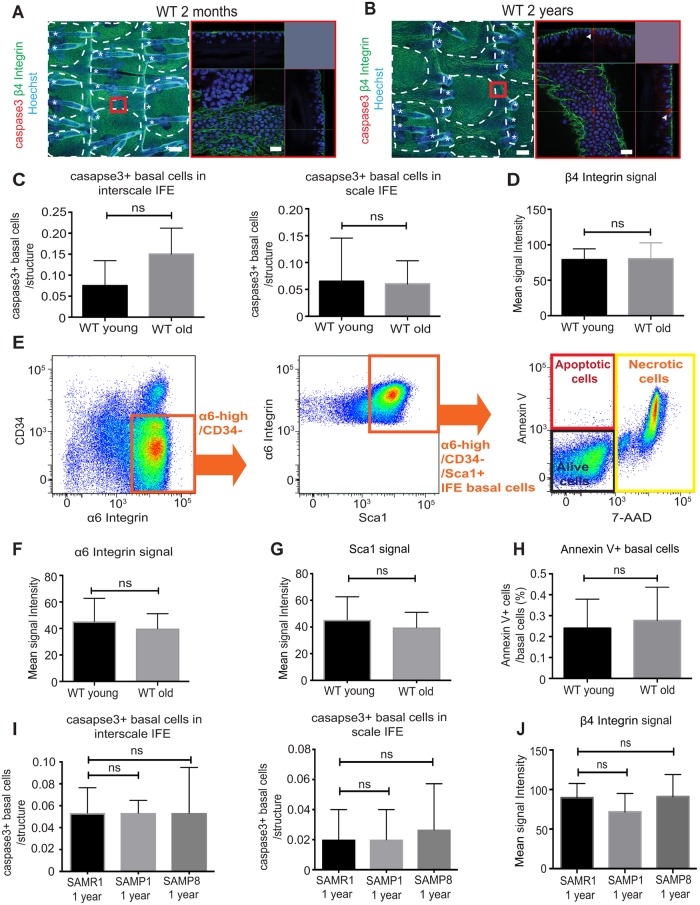
The apoptotosis in the basal layer remains largely unchanged with age.(A, B) Tail whole-mount epidermal sheets are stained with cleaved caspase-3 (apoptosis marker, red), β4 integrin (basal cell marker, green) and Hoechst (blue). (A) and (B) represent the immunostaining of wild-type young (2-month-old) and old (2-year-old) mice. The area within the red box is shown with higher magnification. Arrowhead represents apoptotic cells in the basal layer (B). Asterisks represent hair follicles. White dotted lines represent the boundary of scale and interscale. Scale bars: 100 μm (left) or 20 μm (right). (C) Quantification of the number of caspase3+/β4 integrin+ cells per an interscale or scale structure. The caspase3+ basal cells are scored from ≥50 interscale or scale IFE structures per mouse. N = 4. Error bars show S.E.M. Mann-Whitney U test. ns: non-significant; P = 0.22 in interscale IFE; P = 0.85 in scale IFE. (D) Quantification of the mean signal intensity of β4 integrin. Signal from whole-mount staining shown in (A, B) is measured. N = 4. Student t-test. ns: not significant. P = 0.93. (E) FACS dot plot shows gates to define basal cells in the interfollicular epidermis (α6 integrin+/CD34−/Sca1+), followed by the analysis for 7-AAD and Annexin V signals. (F, G) The mean signal intensity of α6 integrin (F) and Sca1 (G) measured by FACS. N = 3. Student’s t-test. ns: not significant; P = 0.65 (F); P = 0.66 (G). (H) Graph shows the percentage of apoptotic cells (Annexin V+/7-AAD−) in the basal IFE. N = 3. Student’s t-test. ns: not significant; P = 0.77. (I) Quantification of the number of caspase3+/β4 integrin+ cells in SAM mice at 1-year-old. The caspase3+ basal cells are scored from ≥50 interscale or scale IFE structures per mouse. N = 3. Kruskal-Wallis test for multiple comparison is used. ns: non-significant; SAMR1 vs. SAMP1; P > 0.99. SAMR1 vs. SAMP8; P > 0.99 in the interscale IFE and SAMR1 vs. SAMP1; P > 0.99. SAMR1 vs. SAMP8; P > 0.99 in the scale IFE. (J) Quantification of the mean signal intensity of β4 integrin. Signal from whole-mount staining (S2B Fig) is measured. N = 3. One-way ANOVA. ns: not significant; SAMR1 vs. SAMP1; P = 0.57. SAMR1 vs. SAMP8; P = 0.99.